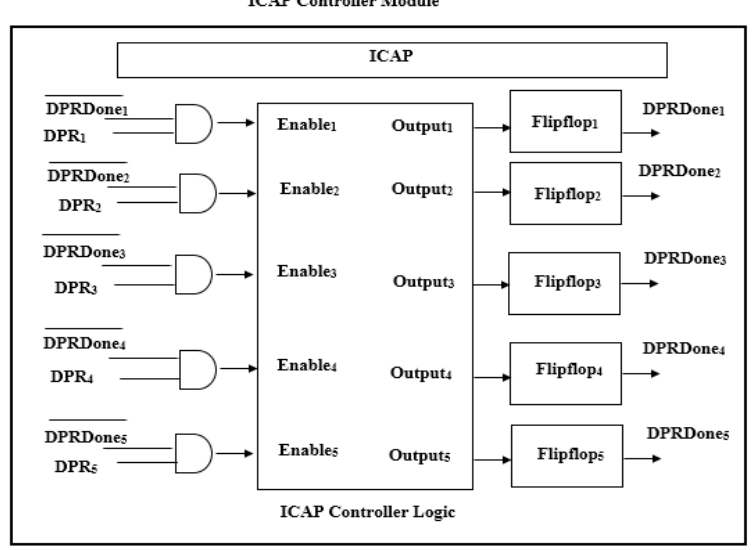
Figure 8. Internal configuration access port (ICAP) controller module.